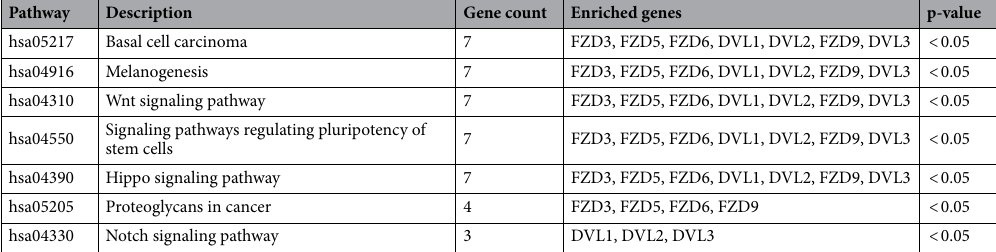
Table 3. Detail of Kyoto encyclopedia of genes and genomes pathway analysis of the CTHRC1 enriched genes.